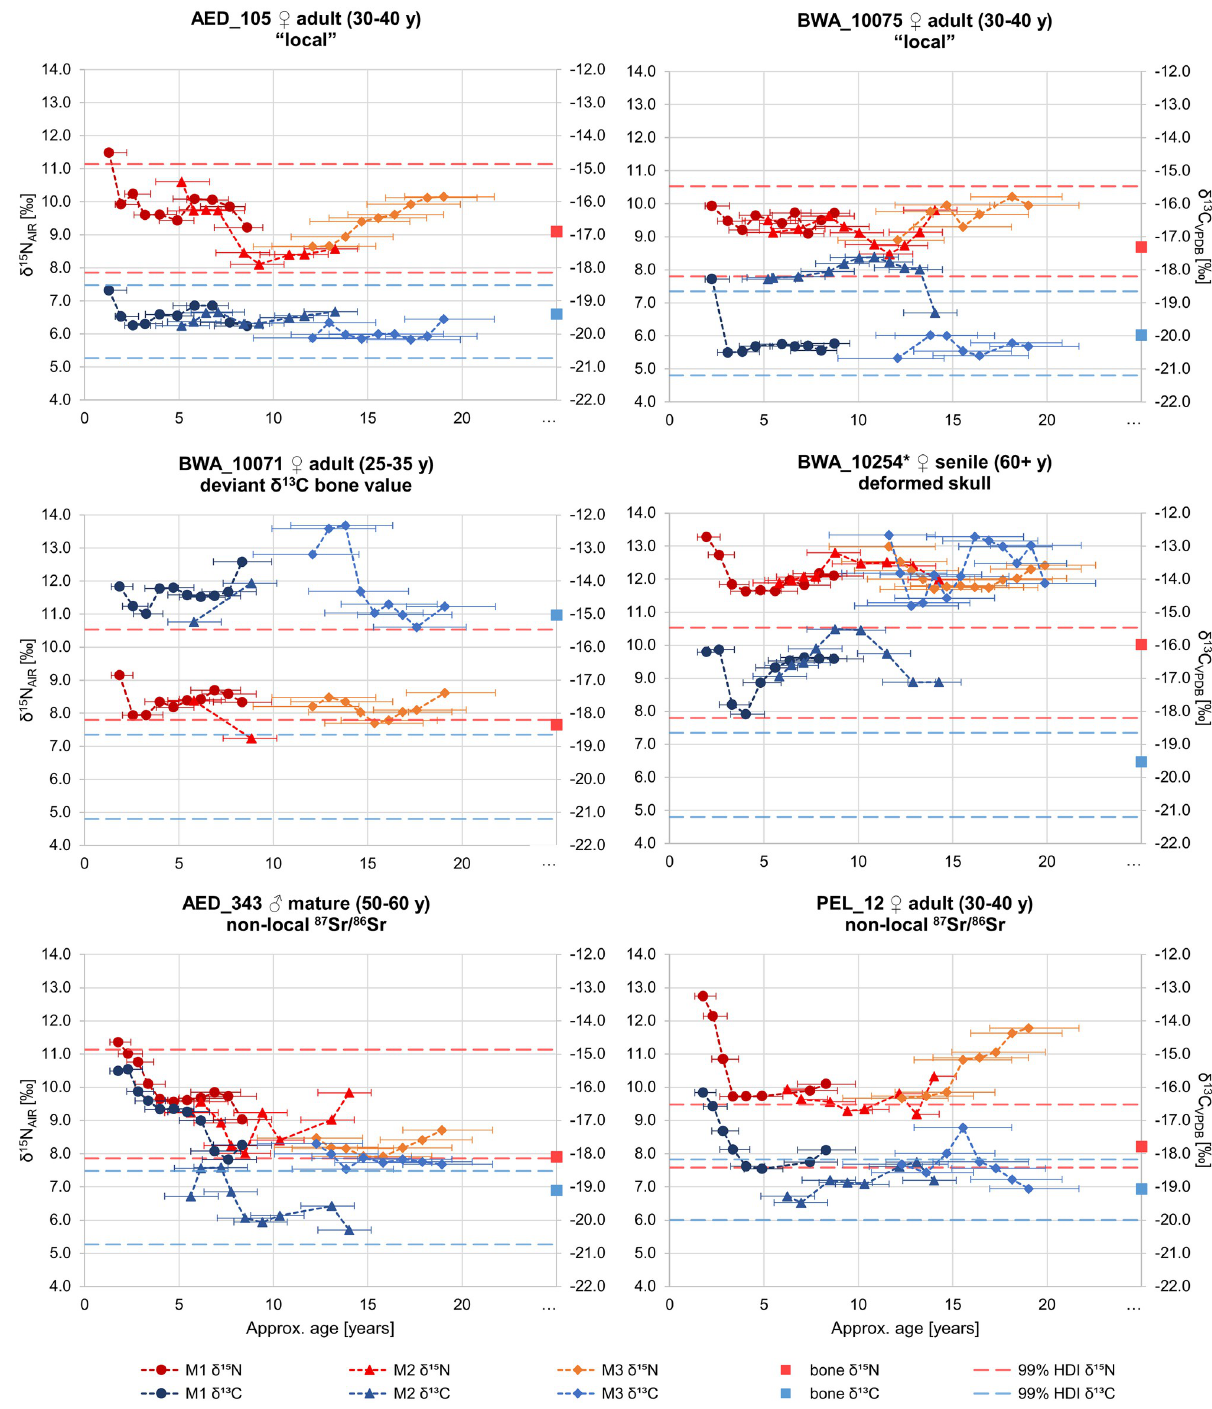
Fig 8. Stable carbon and nitrogen isotope profiles of six selected females (AED_105, AED_343, BWA_10071, BWA_10075, BWA_10254 � , PEL_12). δ 13 C (blue shades) and δ 15 N (red shades) values of collagen from incremental dentine serial sections of molars (M1-M3) and bone collagen (square). Error bars represent the putative timespan each datapoint covers. Dotted lines represent common dietary signals at burial sites (99% HDIs) (illustration: Excel).